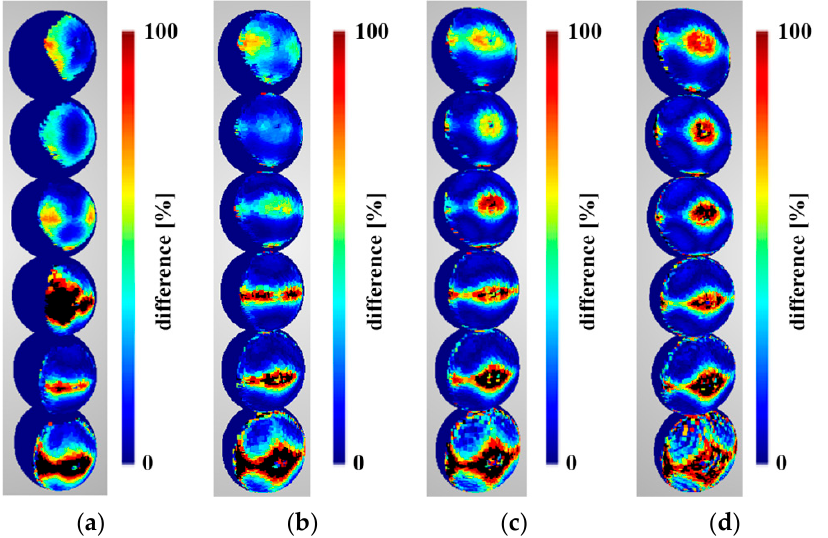
Figure 15. The relative difference between the accuracy predictions and evaluations of the recon- structed sphere at the following distances: ( a ) 2 m, ( b ) 3 m, ( c ) 4 m, and ( d ) 5 m. Spheres in different rows were reconstructed from scenarios with different numbers of cameras. In order from bottom to top, these were as follows: two-, three-, four-, six-, nine-, and twelve-camera scenarios. Values higher than 100% are marked as black.